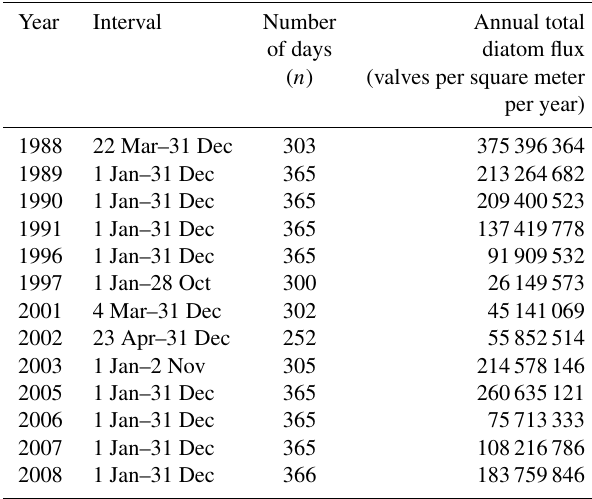
Table 2. Estimates of annual total diatom fluxes. Values were cal- culated for those calendar years with at least 300dyr − 1 of trap col-